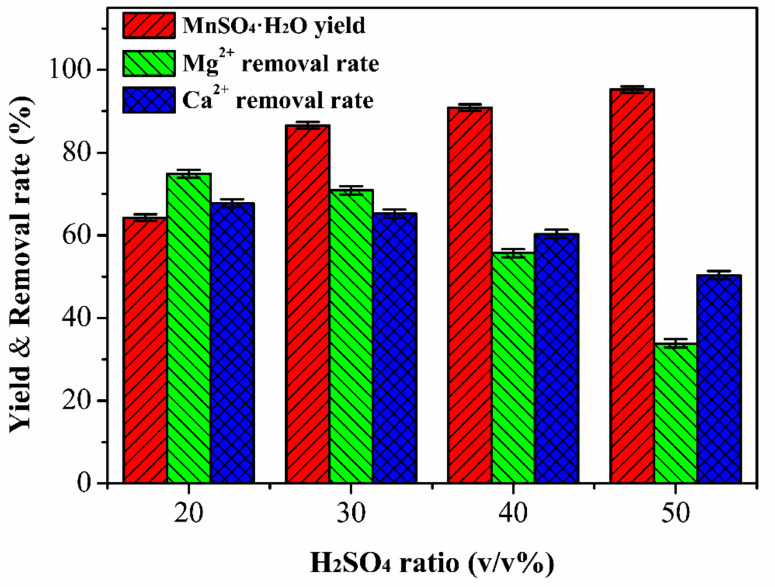
Figure 4. The effect of H 2 SO 4 ratio on MnSO 4 · H 2 O yield and Mg 2+ , Ca 2+ removal